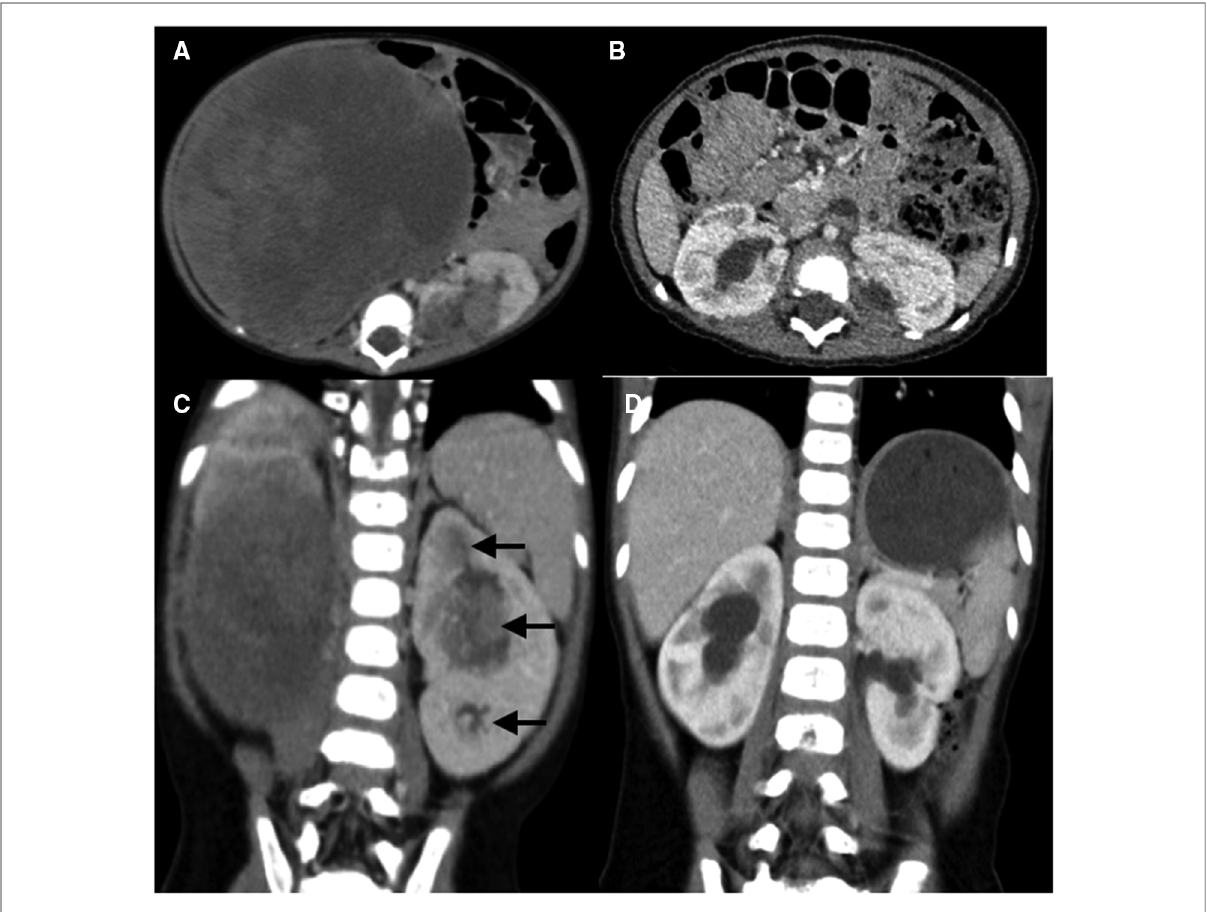
FIGURE 3 Abdominal CT scans of case 6. ( A,C ) Preoperative CT images reveal a huge renal mass in the right kidney and multifocal neoplasms in the left kidney (black arrow), with bilateral renal sinus invasion. ( B,D ) Postoperative CT images reveal multiple perfusion defects in both kidneys and bilateral mild hydronephrosis, without evidence of recurrence or